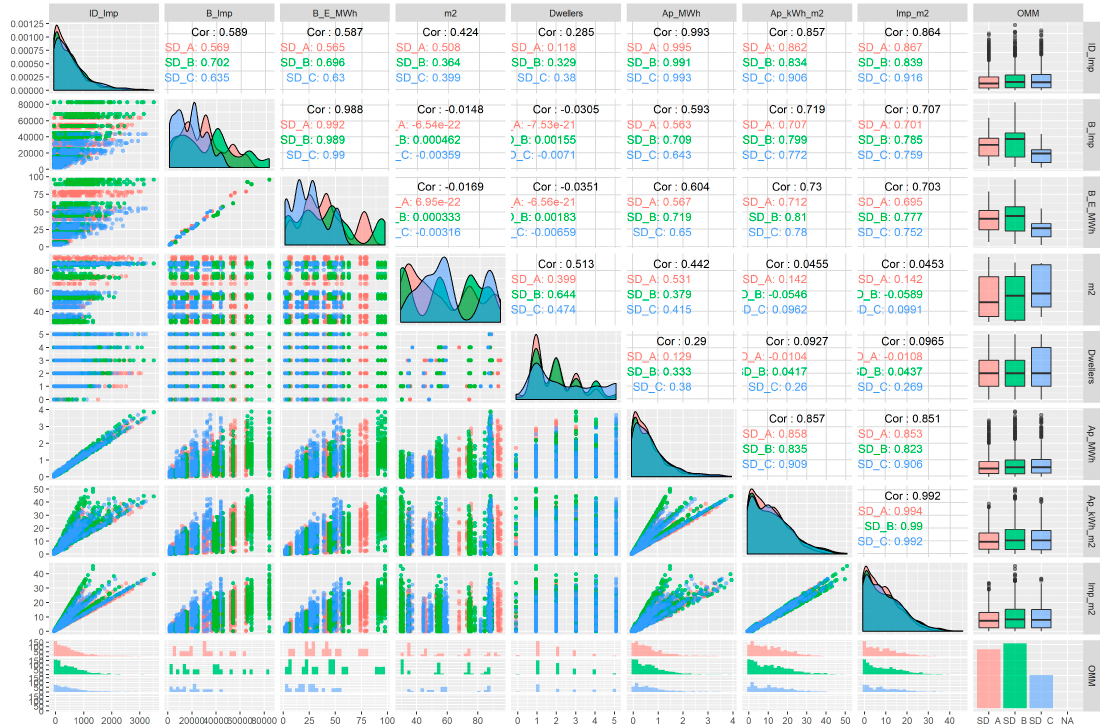
Figure 5. Matrix plot of relevant quantitative variables.